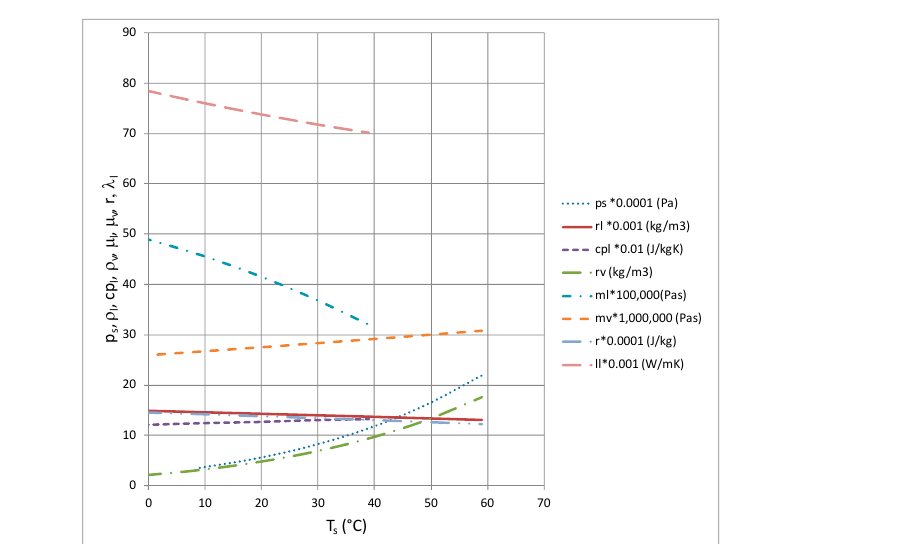
Figure 4. Example properties of HFE 7000 refrigerant [16,17]: saturation pressure p s (ps); heat of evaporation r; specific heat of liquid cp l (cpl); heat conductivity of liquid λ l (ll); liquid density ρ l (rl); Figure 3. The tested stainless steel minichannels. vapor density ρ v ; (rv); liquid viscosity μ l (ml); and vapor viscosity μ v (mv). Table 1. Physical properties of HFE 7000 refrigerant for working temperature 25 °C [17].